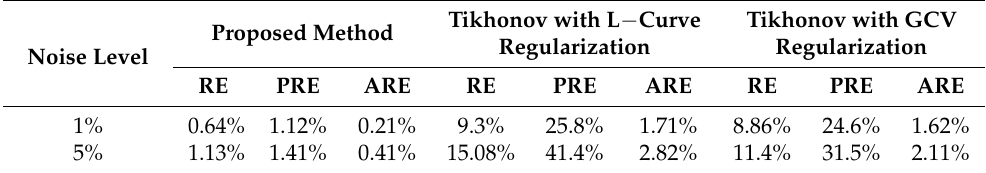
Figure 4. The identification results with 5% noise. ( a ) Proposed method; ( b ) identification error; ( c ) Tikhonov with L − curve regularization; ( d ) identification error; ( e ) Tikhonov with GCV regulariza- tion; ( f ) identification error. Table 3. Calculation time in Example 1. Table 2. Identification error in Example 1.